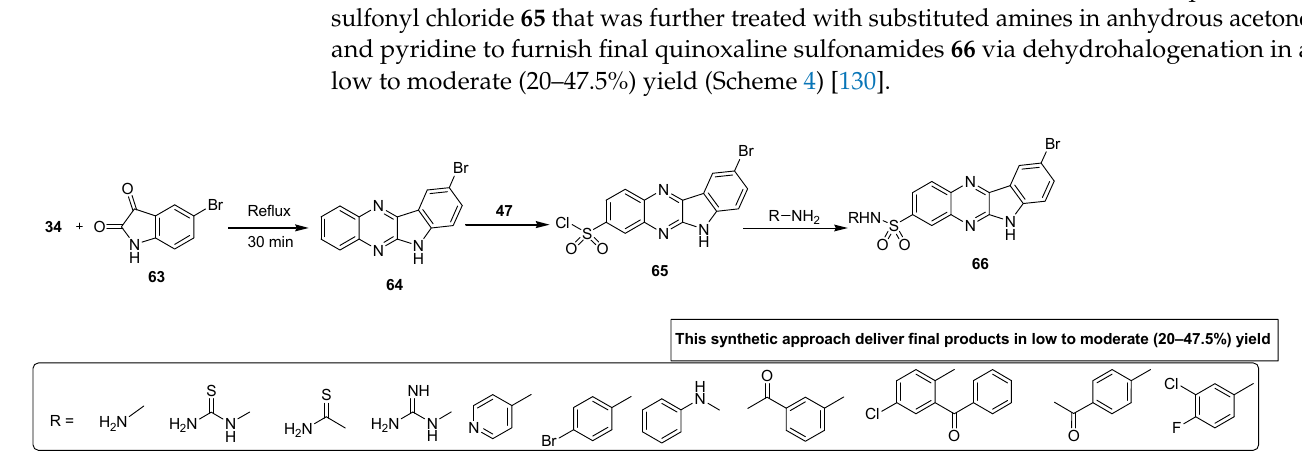
62 Figure 9. Substituted quinoxaline sulfonamide derivatives 59–62 . Table 3. Antibacterial activity of quinoxaline-based substituted benzene sulfonamide derivatives. Compound